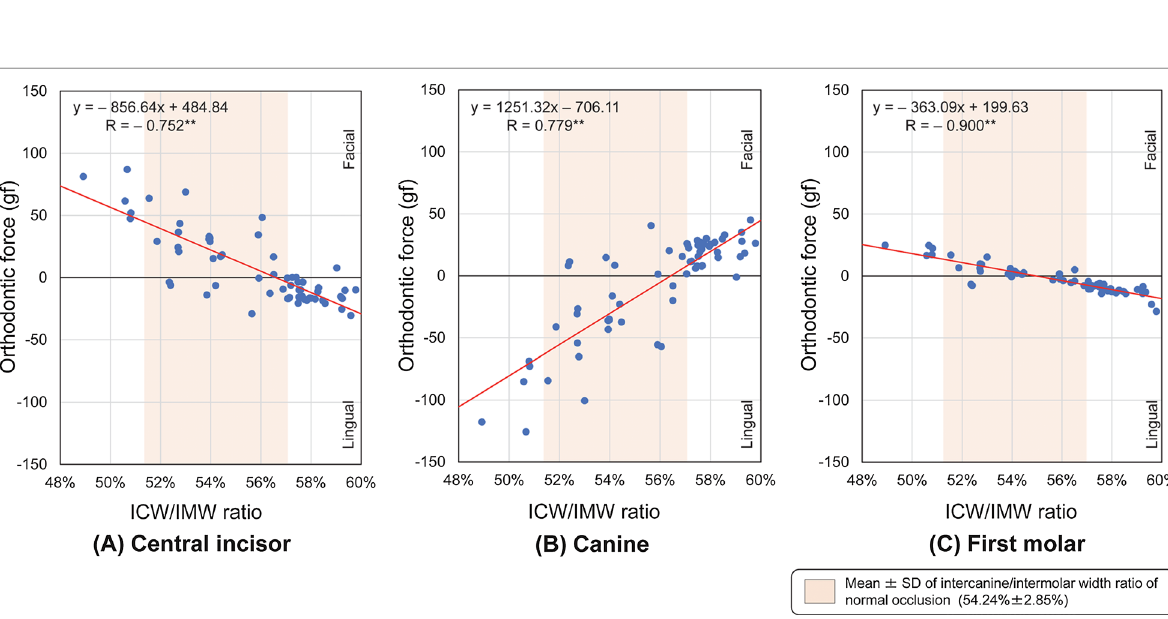
Fig. 6 Spearman correlation coefficients between the intercanine/intermolar width (ICW/IMW) ratio and orthodontic force delivered by 63 types of preformed archwires to the brackets at the A central incisors, B canines, and C first molars. ** P < .01 (Facial: positive, Lingual: